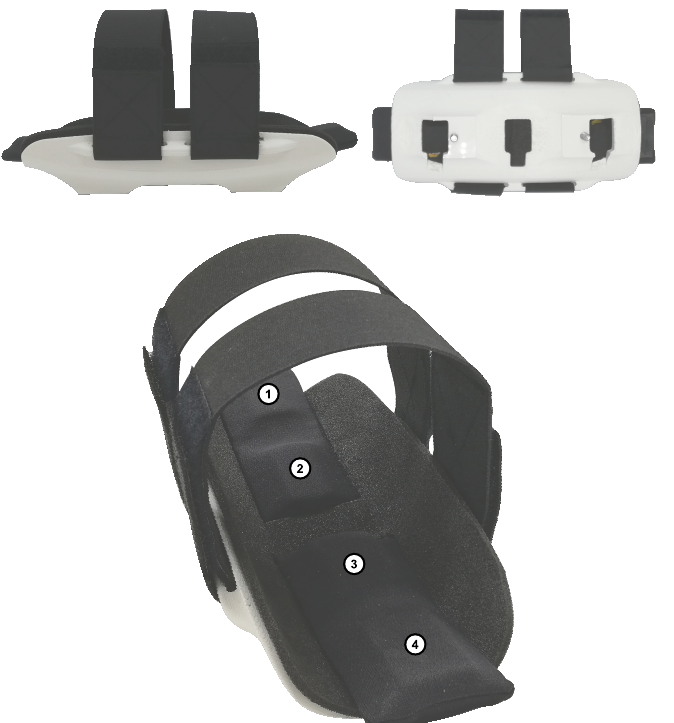
Figure 1. The sensorized shell consists of a three-dimensional (3D) printed shell with four pressure sensors indicated by the numbers 1 to